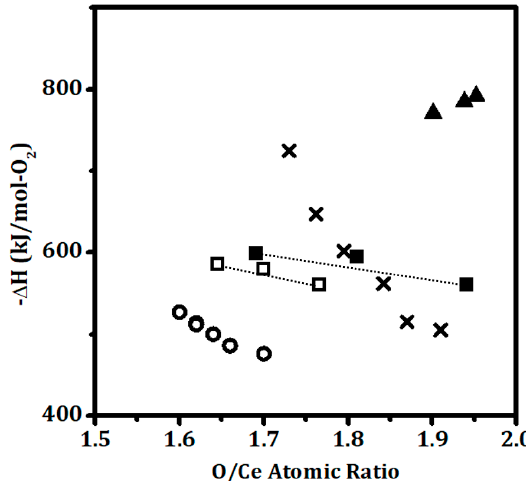
Figure 6. −(cid:1986)(cid:1834) of oxidation as a function of O/Ce ratio for ( ∎ )—20Ce 0.5 Zr 0.5 O 2 -Al 2 O 3 and ( □ )— Figure 6. − ∆ H of oxidation as a function of O/Ce ratio for ( (cid:4) )—20Ce 0.5 Zr 0.5 O 2 -Al 2 O 3 and 20CeO 2 –Al 2 O 3 . Results for ( ▲ )—bulk CeO 2 , ( ○ )—bulk Ce 0.5 Zr 0.5 O 2 , and ( × )—infiltrated CeO 2 on ( (cid:3) )—20CeO 2 –Al 2 O 3 . Results for ( (cid:78) )—bulk CeO 2 , ( )—bulk Ce 0.5 Zr 0.5 O 2 , and ( × )—infiltrated CeO alumina-based support are obtained from previous work for comparison [19]. (cid:35)